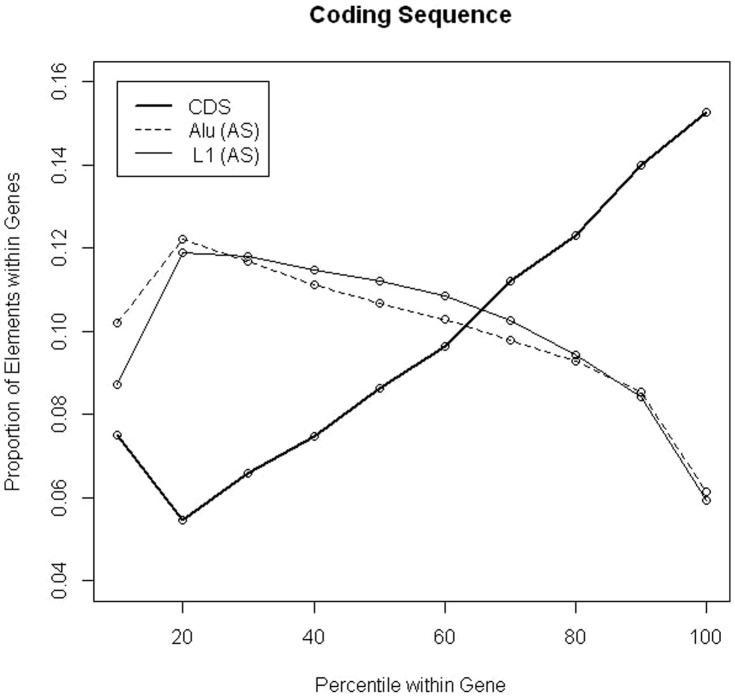
Exon density increases linearly across a gene.All CDS exons within the UCSC Genome Browser RefSeq track (Hg19) were used for this analysis. Counts of CDS exons were tabulated per decile in all RefSeq genes and normalized by the total number of CDS exons in all genes (solid bold line). The antisense oriented (AS) frequencies for L1 (solid thin line) and Alu (broken thin line) are included to exhibit the inverse relationship between antisense distribution and CDS density (Pearson's correlation coefficient: −0.94, p<5.21e-05).